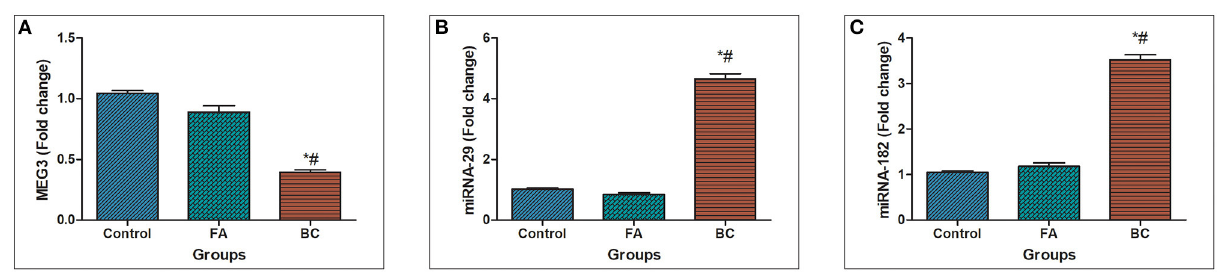
FIGURE 1 | MEG3, miRNA-29, and miRNA182 expression levels in serum. (A) Fold change in serum expression MEG3 level in patients with BC ( n = 180) and fibroadenoma ( n = 120) relative to healthy subjects ( n = 150). (B) Fold change in serum expression miRNA-29 level in patients with BC ( n = 180) and fibroadenoma ( n = 120) compared with healthy subjects ( n = 150). Values are expressed as mean ± SEM (95% CI). (C) Fold change of serum expression miRNA-182 level in patients with BC ( n = 180) and fibroadenoma ( n = 120) compared with healthy subjects ( n = 150). *Significant difference from the control group at p < 0.05. # Significant difference from FA group at p < 0.05.